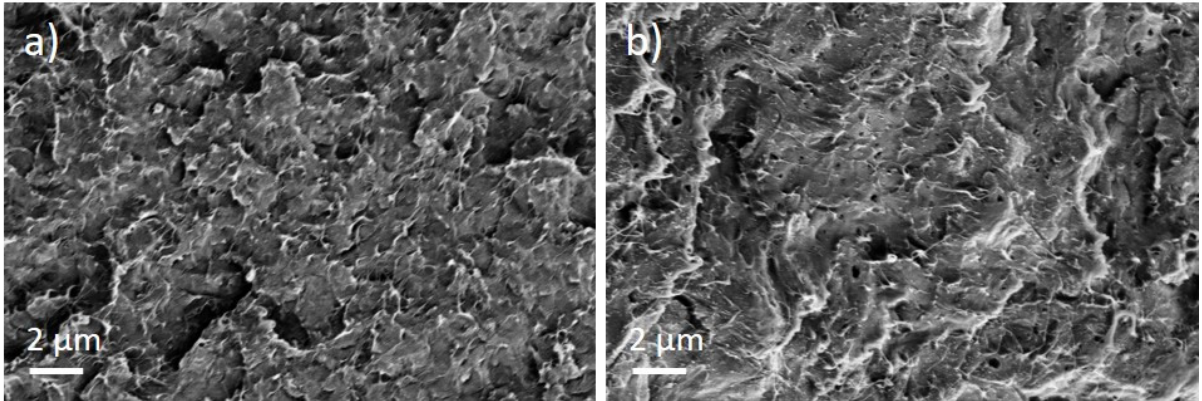
Figure 9. Scanning electron microscopy images of cryo-fracture of ( a ) PBT/2 wt% Tuball™ without PEG and ( b ) with 3 wt% PEG.